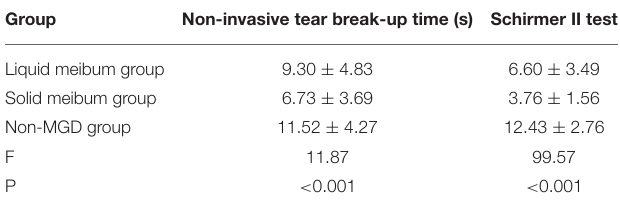
TABLE 2 | Non-invasive tear breakup time and Schirmer II test